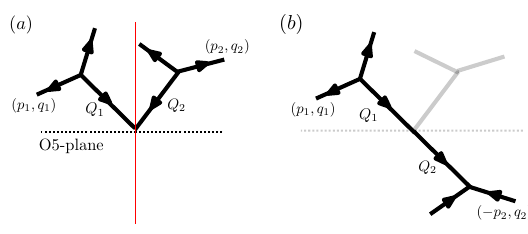
Figure 13 . The rule how to interpret the web diagram with the O5-plane depicted in figure (a). With respect to the O5-plane, we flip the sign of the first elements of the charge vectors. These are all the Kähler parameters which are necessary to compute the 2 -instanton con-